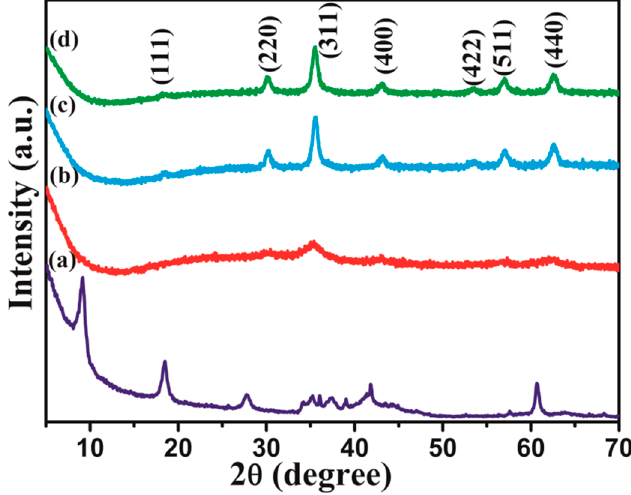
Figure 1. XRD patterns of ( a ) Ti 3 C 2 T x MXenes, ( b ) precursor of 2 wt.% Ti 3 C 2 T x /NiZn ferrite, precursors hydrothermally treated at 200 ° C for 2 h: ( c ) Ni 0.5 Zn 0.5 Fe 2 O 4 , ( d ) 2 wt.% Ti 3 C 2 T x /NiZn ferrite.